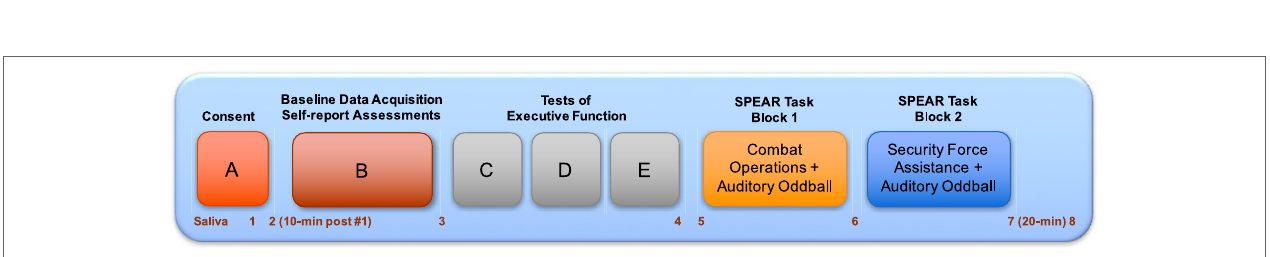
FigUre 2 | Adaptability protocol. Task events are illustrated and saliva sampling frequency noted. Obtaining the informed consent (a) was followed by completion of self-report assessments, instrumentation and the baseline assessments (B) . The Ericksen-Flanker, Iowa Gambling Task, and 2-Back tests of executive function were then administered [ (c–e) , respectively]. The Soldier Performance and Effective, Adaptable Response (SPEAR) task Combat Operations and Security Force Assistance blocks of trials were then completed (orange and blue boxes). Following each of the tests of executive function and both SPEAR blocks of trials, the participant sat quietly for 2-min for a post-task recovery period. The saliva sample acquisition schedule is noted at the bottom of the figure in red text.